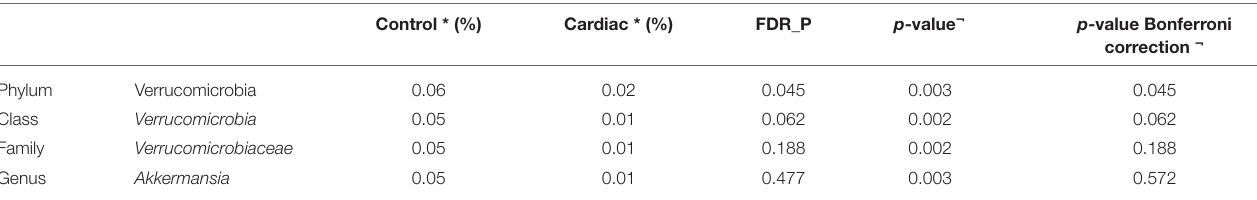
TABLE 3 | Abundance of organisms in the fecal microbiome of the cardiac phenotype of Chagas disease and control group.